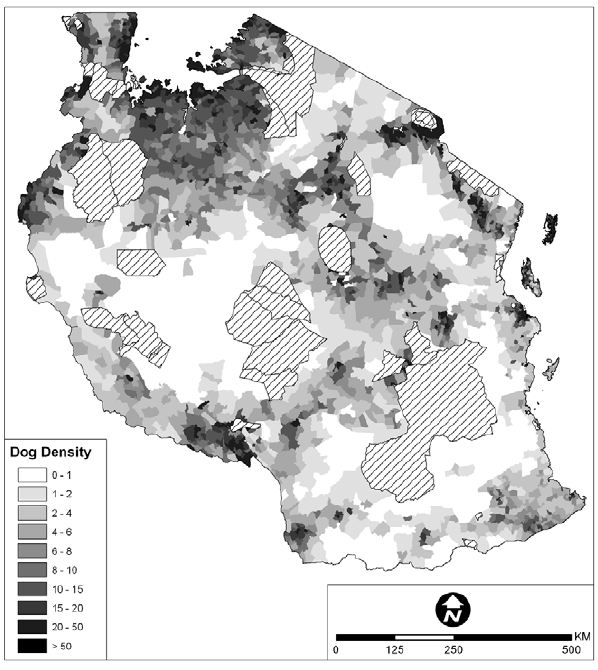
Figure 3. ‘Dog density’ map of Tanzania (courtesy of Hawthorne Beyer; data source: LXV in Appendix S1). Hashed areas represent the location of wildlife protected areas.